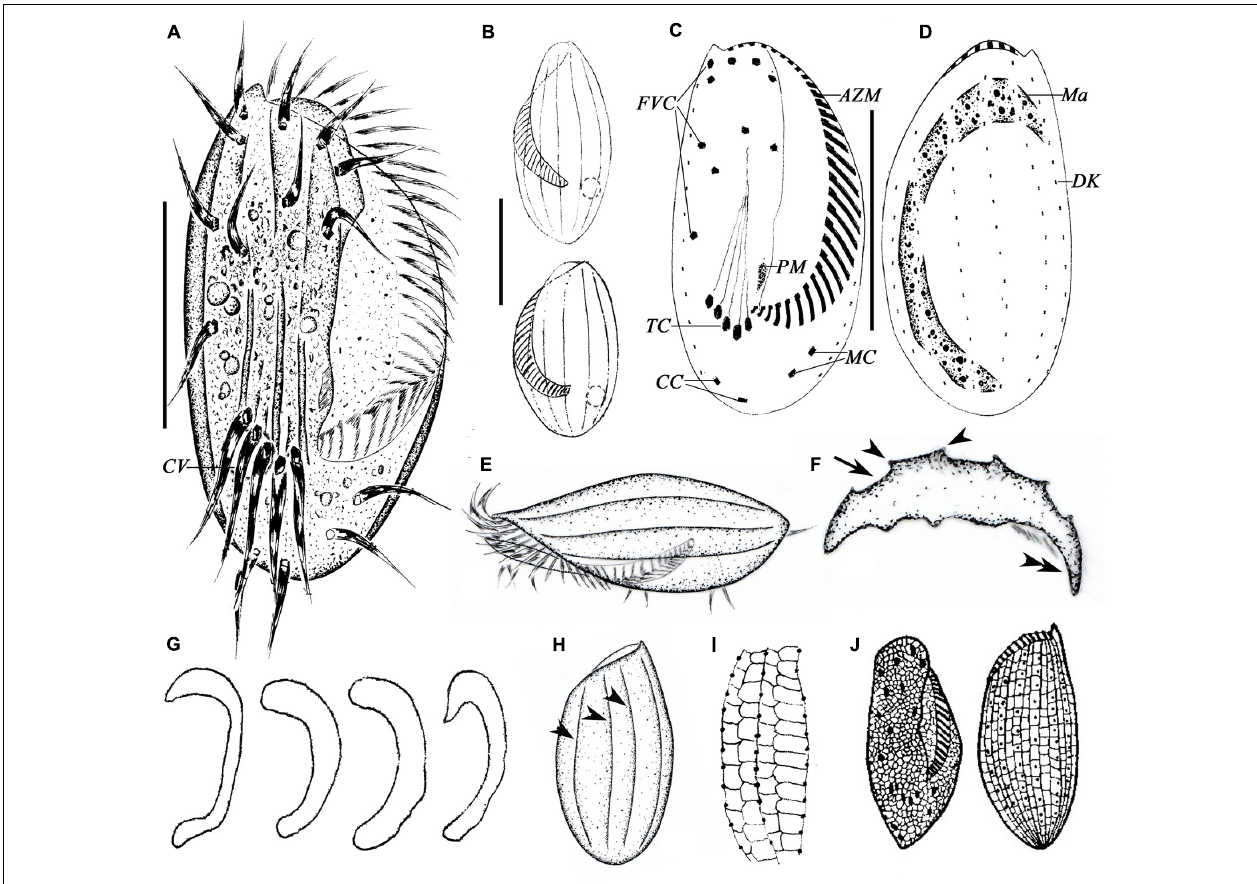
FIGURE 3 | Morphology of E. antarcticus Fenchel and Lee, 1972 in vivo (A,B,E,F,H) , after protargol (C,D,G) and silver nitrate (I,J) impregnation. (A) Ventral view of a representative specimen. (B) Dorsal views of different body shapes. (C,D) Ventral (C) and dorsal (D) views of the same specimen showing the ciliary pattern and nuclear apparatus. (E) Left lateral view showing the AZM and the dorsal ridges. (F) Cross section view to show bended left and right margins (double-arrowhead), note the furrows (arrow) and ridges (arrowheads) on dorsal side. (G) Different shapes of macronucleus. (H) Dorsal view to show the ridges (arrowheads). (I) Details of the silverline system of dorsal side. (J) Ventral and dorsal views, from Curds (1975). AZM, adoral zone of membranelles; CC, caudal cirri; CV, contractile vacuole; DK, dorsal kinety; FVC, frontoventral cirri; Ma, macronucleus; MC, marginal cirri; PM, paroral membrane; TC, transverse cirri. Scale bars = 30 µ m.